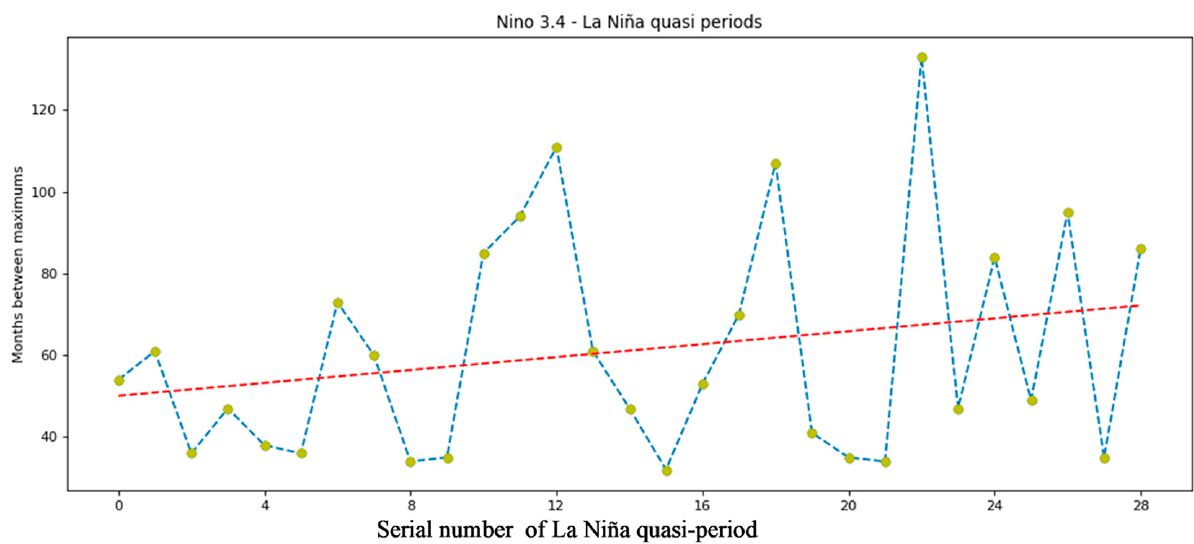
Figure 3. Illustration of quasi-periodicity (time between consecutive maxima of El Niño episodes), based on Table S1. Numbers of episodes follow from this table. In this and following plots of quasi-periodicity, a regression line is added in red.